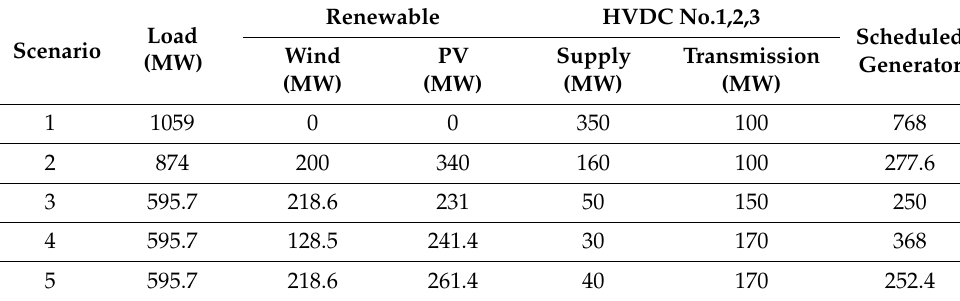
Table 5. Scenario C configuration (HVDC No.3 transmission).